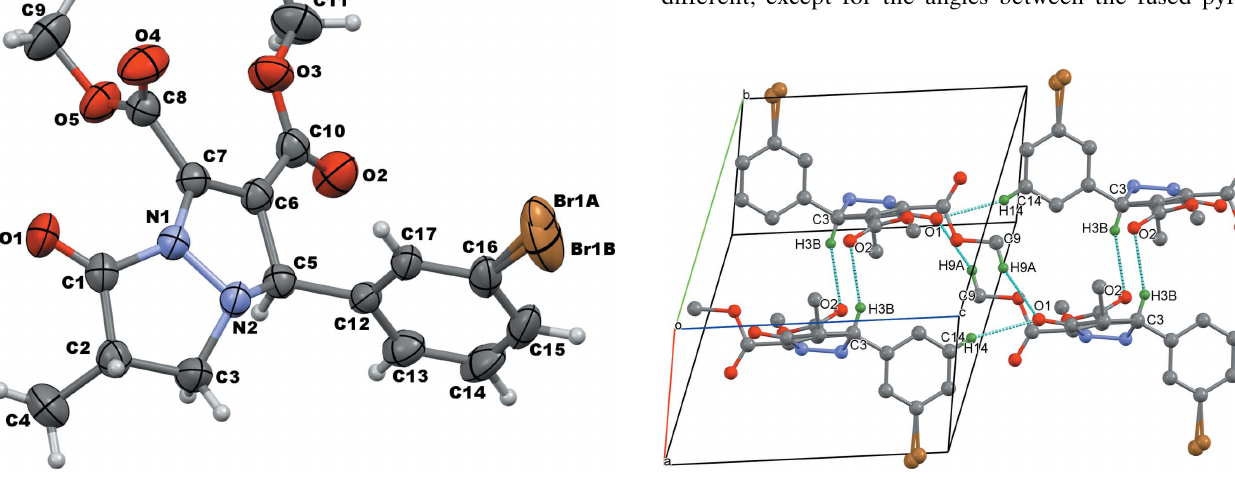
Figure 2 Crystal packing for the title compound showing hydrogen bonds as dashed blue lines.